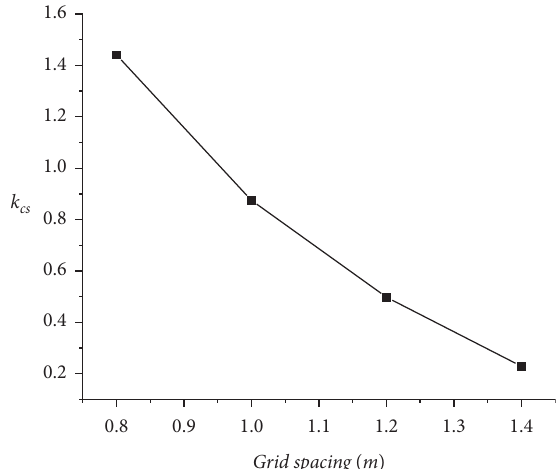
Figure 18: Variation in the yield acceleration coefficient with vertical spacing of bars.